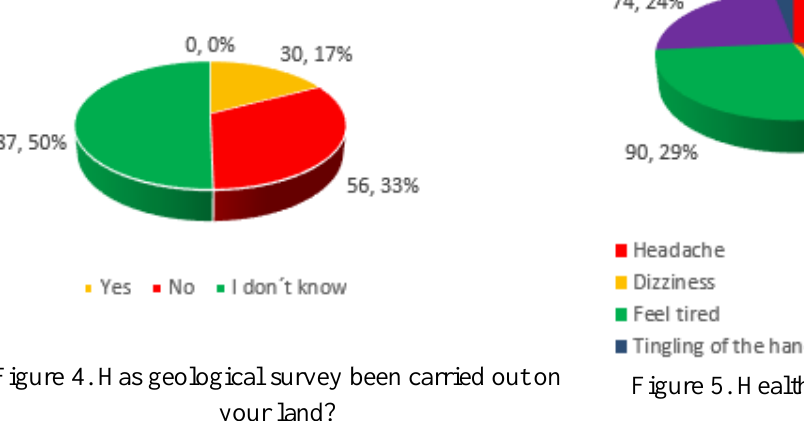
Figure 5. Health problems when using electronic